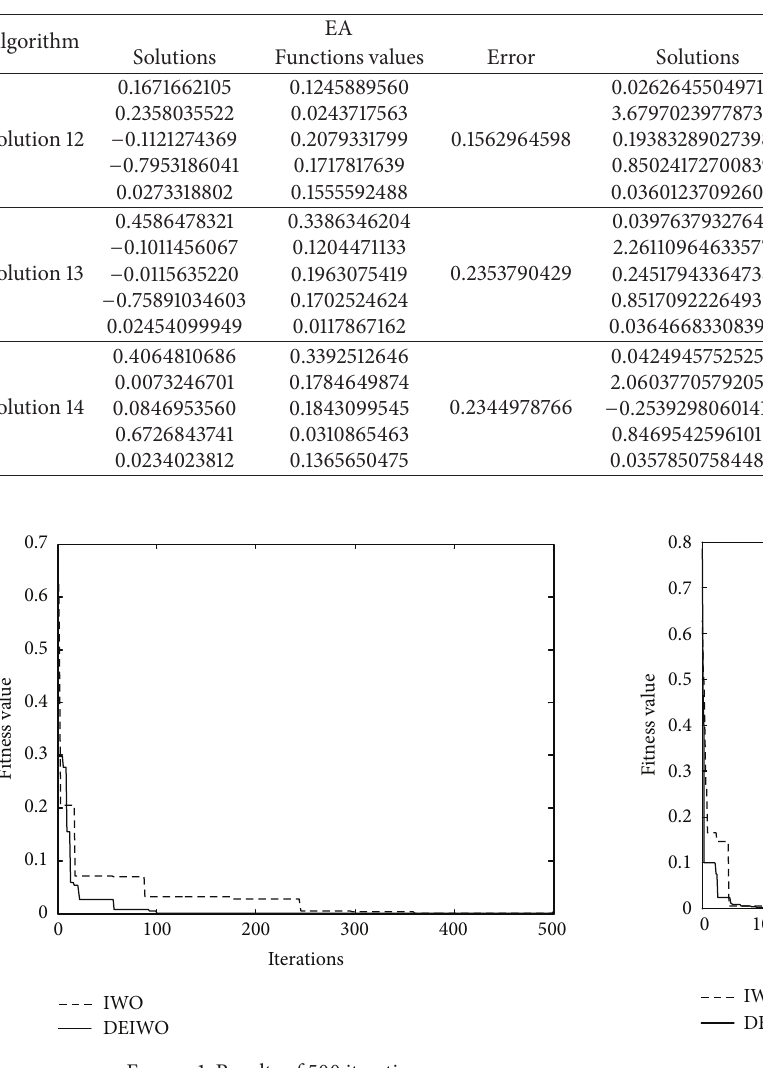
Figure 1: Results of 500 iterations. Figure 2: Results of 800